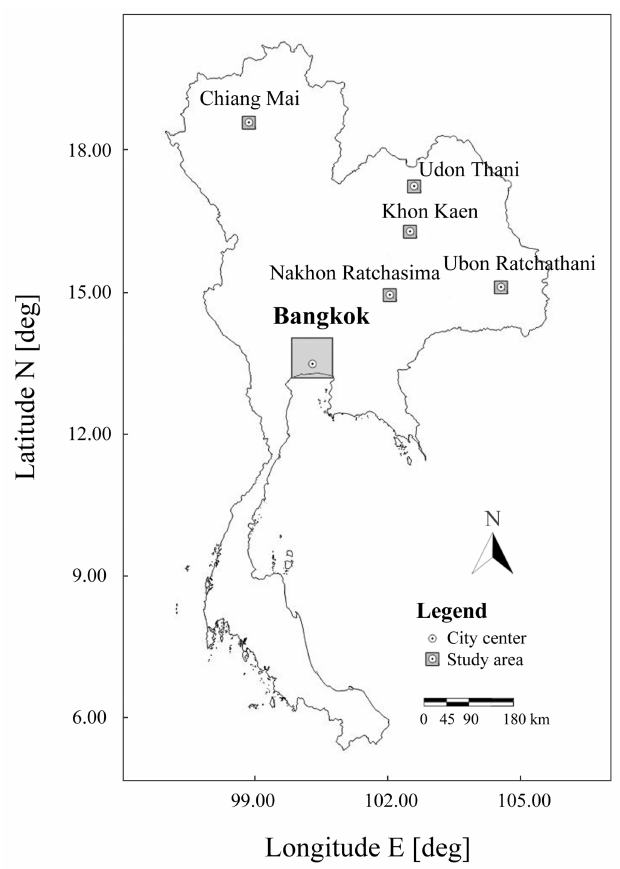
Figure 1. Location of the analyzed six cities on a Thailand administrative boundary